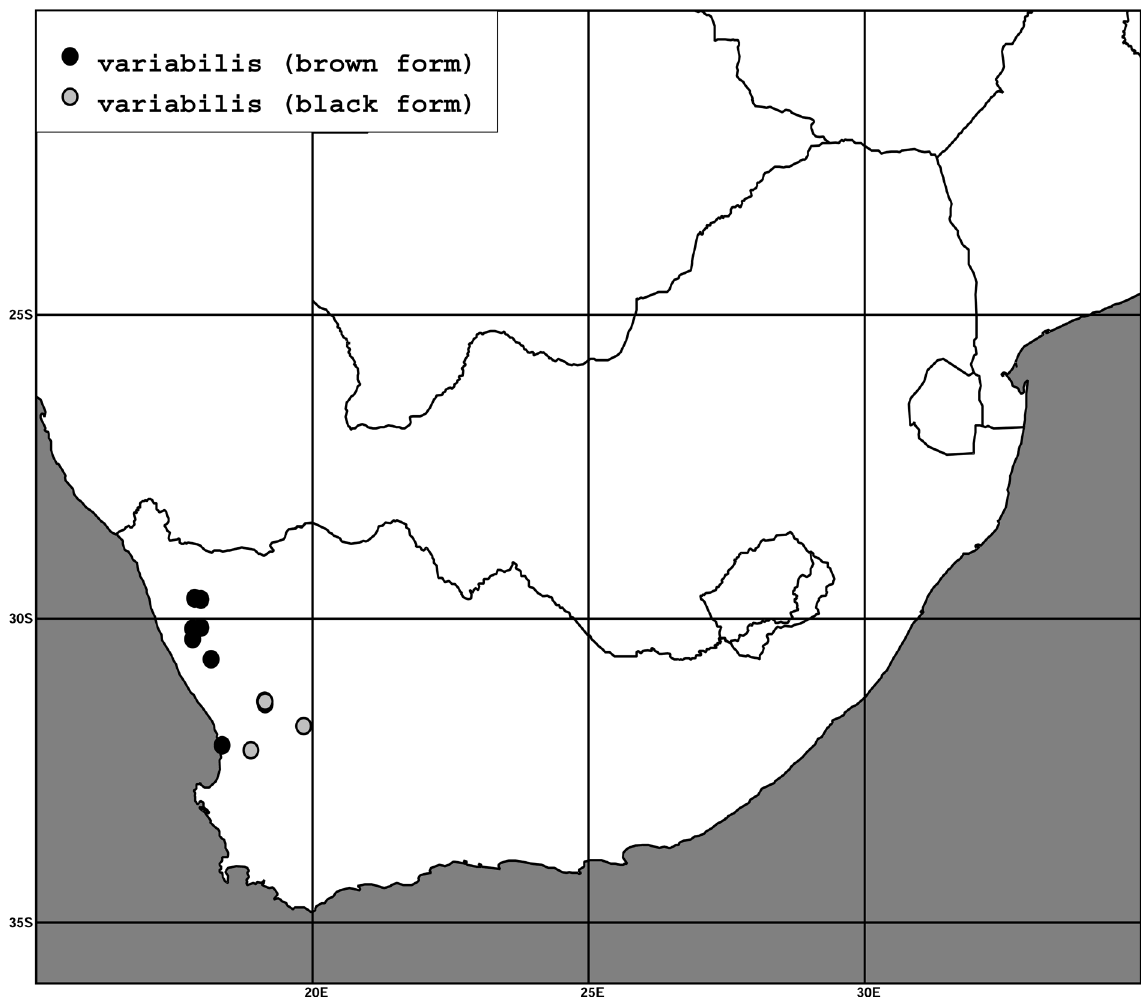
Fig. 17. Distribution of Redivivoides variabilis sp. nov. in South